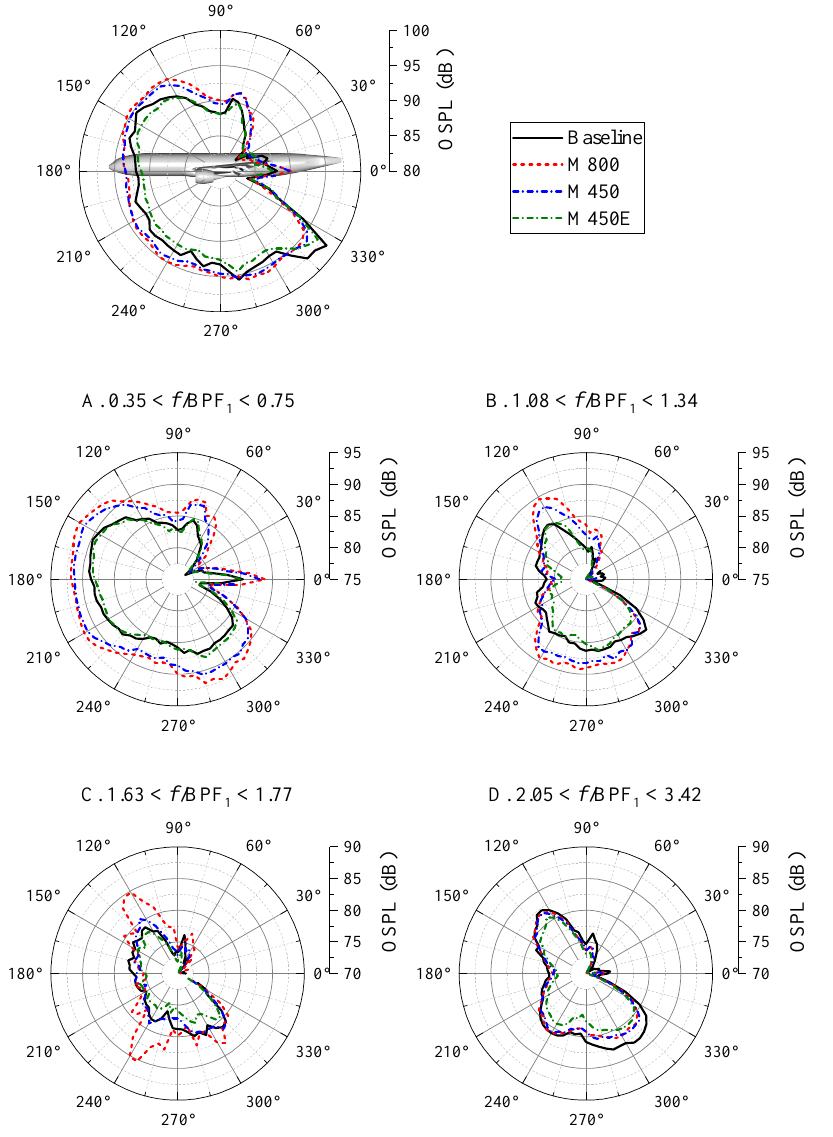
Figure 19. The noise directivity pattern along the lateral axis. Directivity plots A to D correspond to the frequency bands where notable discrepancies between the modified and baseline configurations are present in Figure